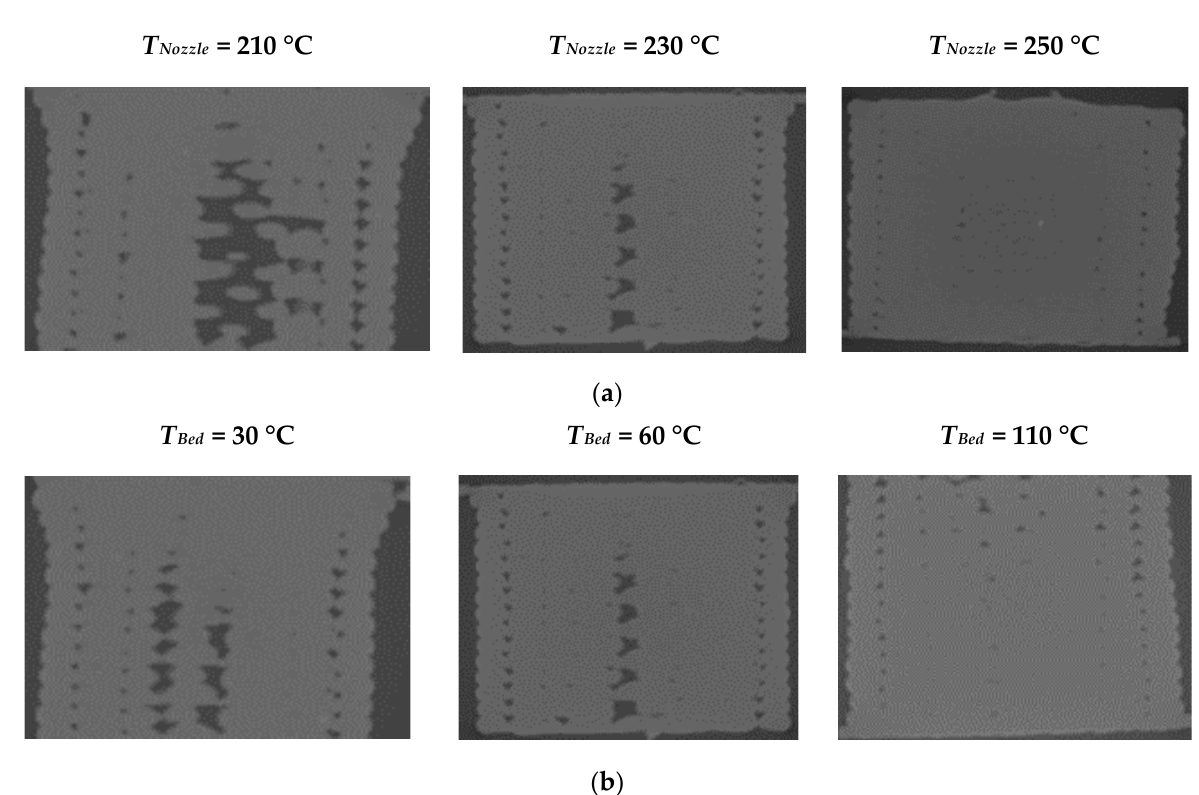
Figure 15. Example of the porosity distribution between adjacent printed filaments at a nozzle tem- perature of 250 °C.